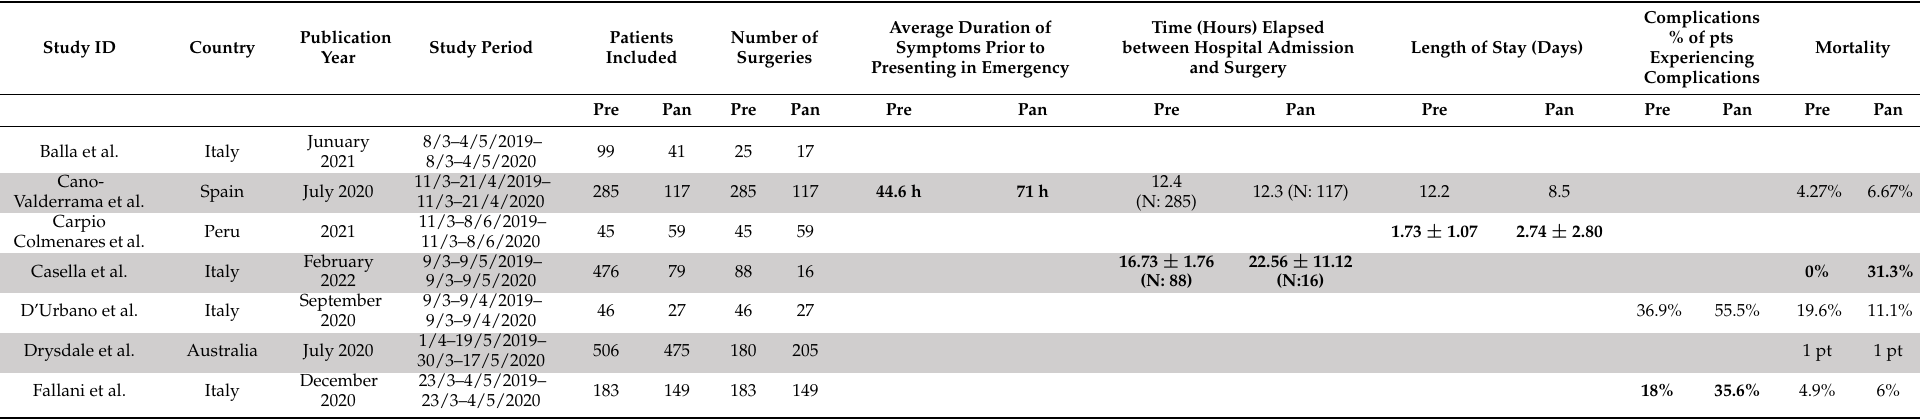
Table A3. Results of the included